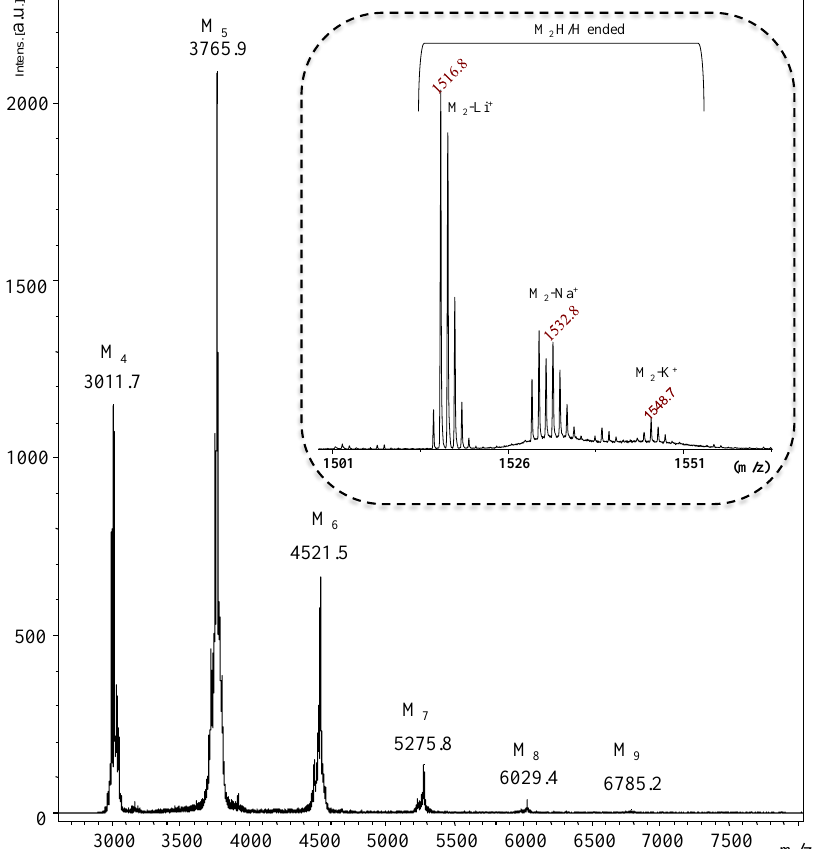
Figure 9. Matrix assisted laser desorption / ionization-time of flight (MALDI-TOF) mass spectrum of poly-6-MOEG-9-T- BF3k -FE (i.e., the sample obtained by the standard procedure consisting of the fast solvent evaporation at reduced pressure into a rotary evaporator apparatus). The inset displays an enlarged section of the mass spectrum recorded in reflectron mode using DCTB as matrix and CF 3 COOLi salt as doping agent.